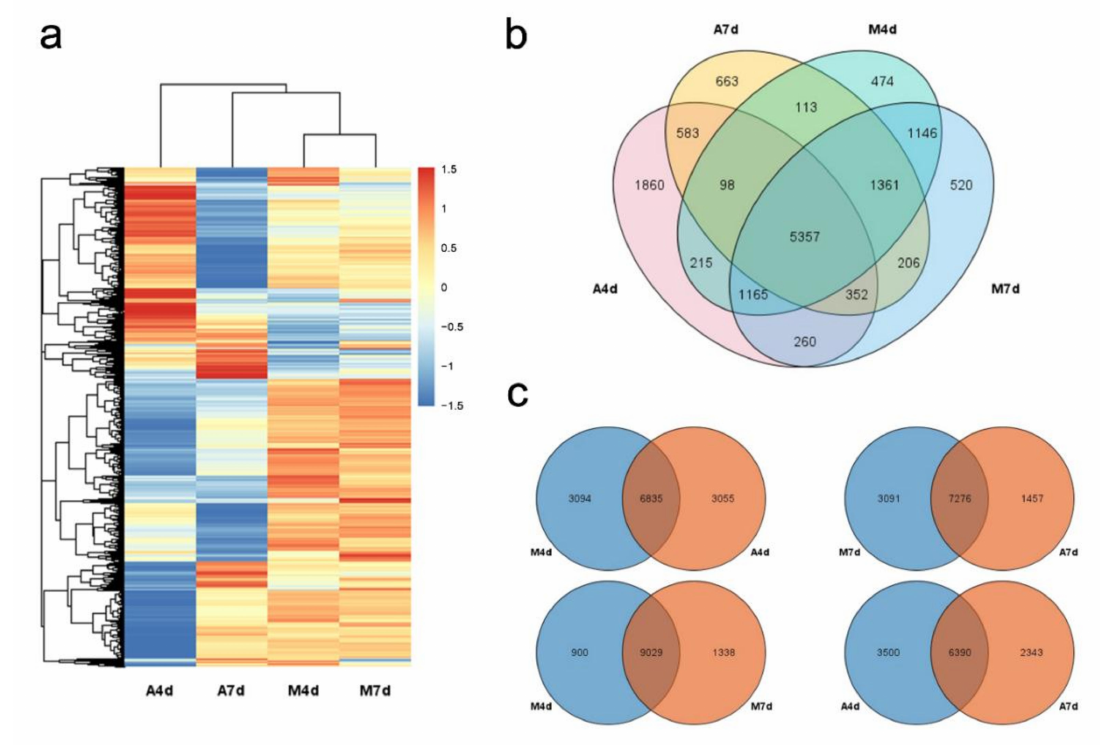
Figure 2. The abundance of genes expression across rice genome under alkaline stress with high pH condition. ( a ) The pattern of gene expression among all detection in A4d, A7d, M4d and M7d. ( b , c ) Comparative Venn analysis of common and unique genes expressed in different time points (4d, 7d) among stress and mock in